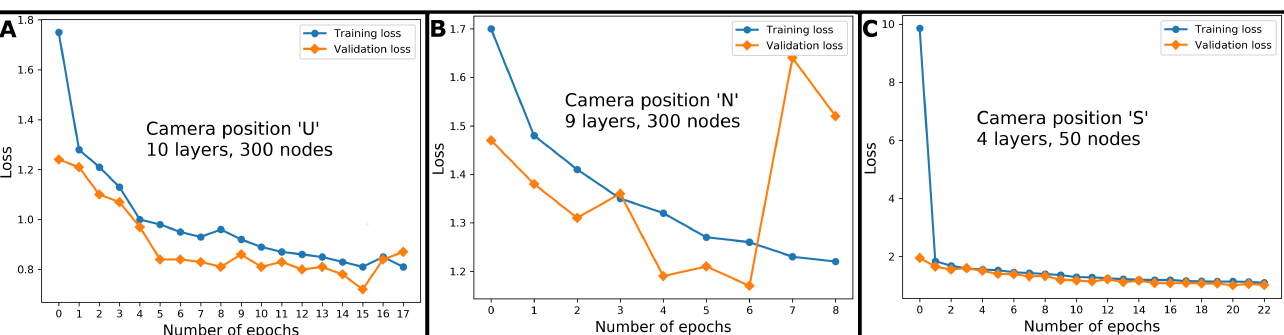
Figure 4. Accuracy depending on the number of neighbours in training a kNN classifier for camera positions ‘U’ (figure part A ), ‘N’ (figure part B ) and ‘S’ (figure part C ). The hyperparameter k was tuned via grid search with five fold cross-validation.